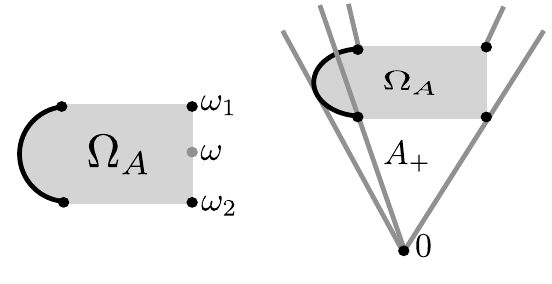
Figure 6: An arbitrary state space and its pure states (black points in Ω